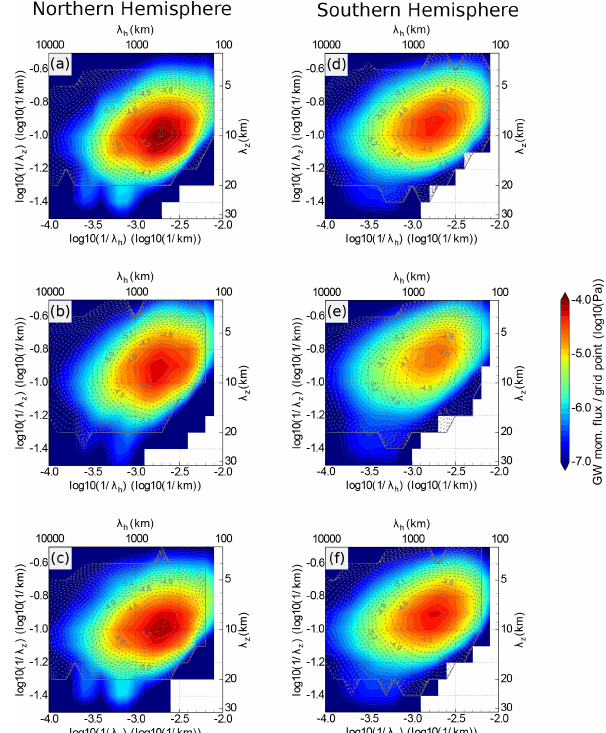
Figure A1. Observed spectra for different hemispheres for 3 con- secutive years. Panels (a, b, c) Show spectra averaged for boreal summer (June-August) for 2005, 2006, 2007 respectively; pan- els (d, e, f) show spectra averaged for austral summer (December– February) for 2005/6, 2006/7, 2007/8. All spectra are averaged over three regions of deep convection of each hemisphere as shown in Fig. 2.